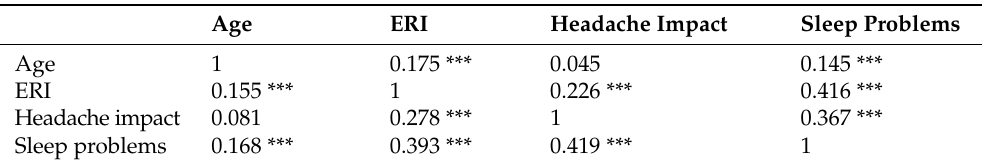
Table 2. Bivariate correlation between age, effort/reward imbalance, headache impact, and sleep quality. Values in the lower triangle are zero-order Pearson’s correlations; values in the upper triangle are Spearman’s